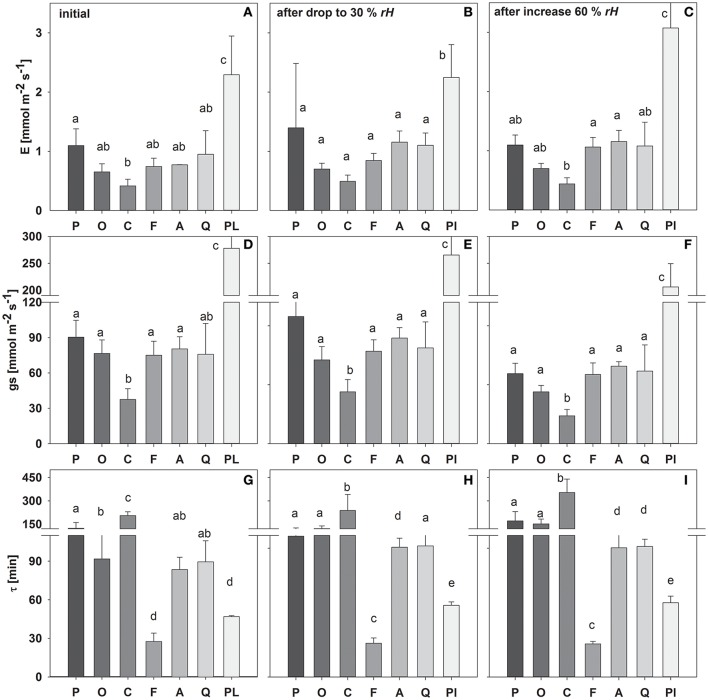
Mean transpiration rate (E), stomatal conductance (gs) and time constant (τ) during the initial experimental phase (A,D,G), following a drop in rH (B,E,H) and an increase in rH (C,F,I). Species are sorted as follows: P. abies, O. triangularis, C. arabica, F. sylvatica, A. longifolia, Q. suber, P. lanceolata. Lower case letters indicate statistical differences between species (p < 0.05).